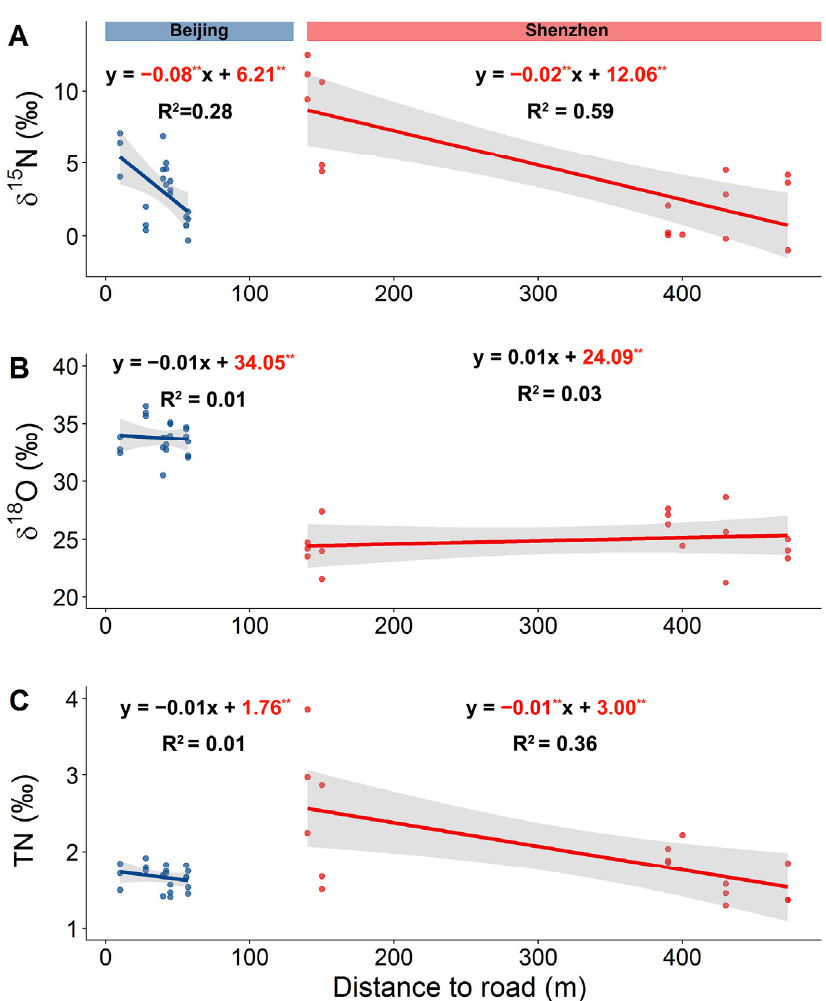
Figure 4. Relationship between highway distance and ( A ) δ 15 N, ( B ) δ 18 O, and ( C ) TN of urban tree leaves. (Note: The coefficients of the linear regression model are displayed above the regression line. The shaded area represents a 95% confidence interval of the fitted value. The significant coefficients of the linear regression are marked in red. Significance of coefficients: ** for p < 0.01).